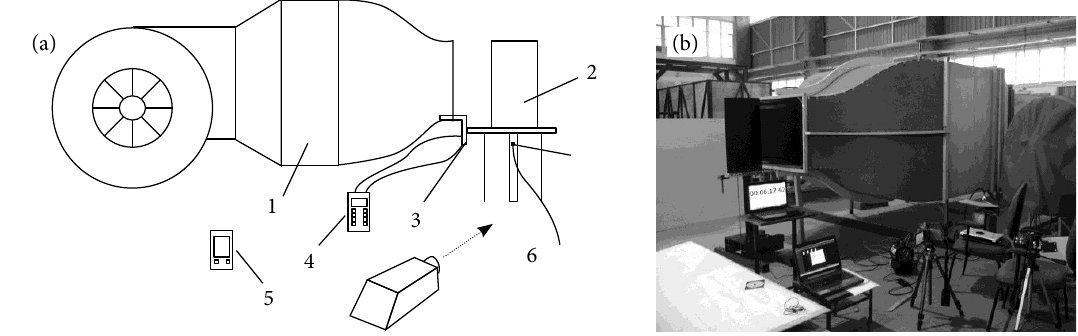
Figure 13. Scheme (a) and picture (b) from the experimental apparatus used for flutter detection with infrared imaging.